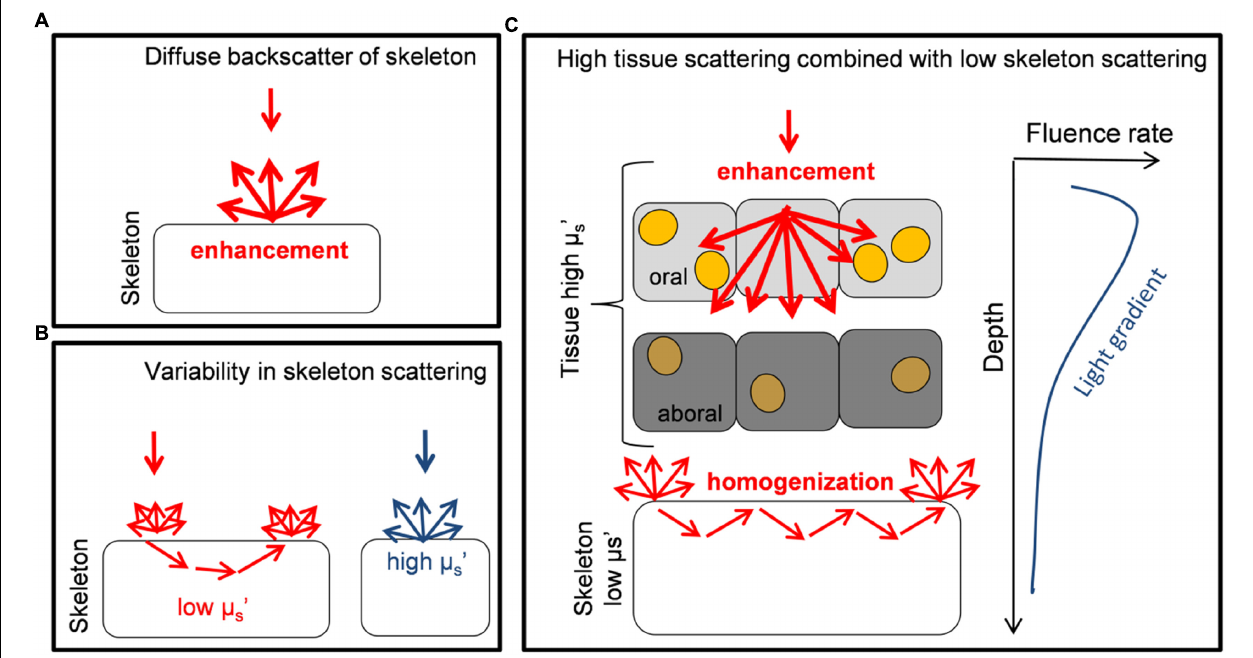
FIGURE 6 | Schematic diagram illustrating different optical strategies of corals. (A) The diffuse backscattering properties of skeletons from the coral Porites branneri have been measured and it was shown that the skeleton was highly reflective with an almost isotropic distribution of the backscattered light. Such scattering can lead to a diffusely enhanced light field for Symbiodinium (based on Enriquez et al., 2005). (B) Low-coherence enhanced backscattering spectroscopy has been used to identify that the optical properties of coral skeletons show a great variability in the microscopic reduced scattering coefficient µ s ’ (for short photon pathlengths). It is shown that a continuum of skeletal scattering properties exist, which are affected by the fractal dimensions of the skeleton (based on Marcelino et al., 2013). (C) Monte Carlo simulations are used to identify the optical properties of live faviid corals including intact coral tissue. A combination of light transport is identified where the tissue strongly scatters and enhances irradiance locally, while the skeleton homogenizes and distributes light to otherwise shaded areas. These two optical strategies are used to counteract the light gradient present in coral tissues. Symbiodinium cells (yellow dots) in oral tissue layers receive high amounts of light while in aboral tissue layers irradiance is reduced and Symbiodinium (dark orange) uses the remaining low light efficiently (based on this study and Wangpraseurt et al., 2012, 2014a,